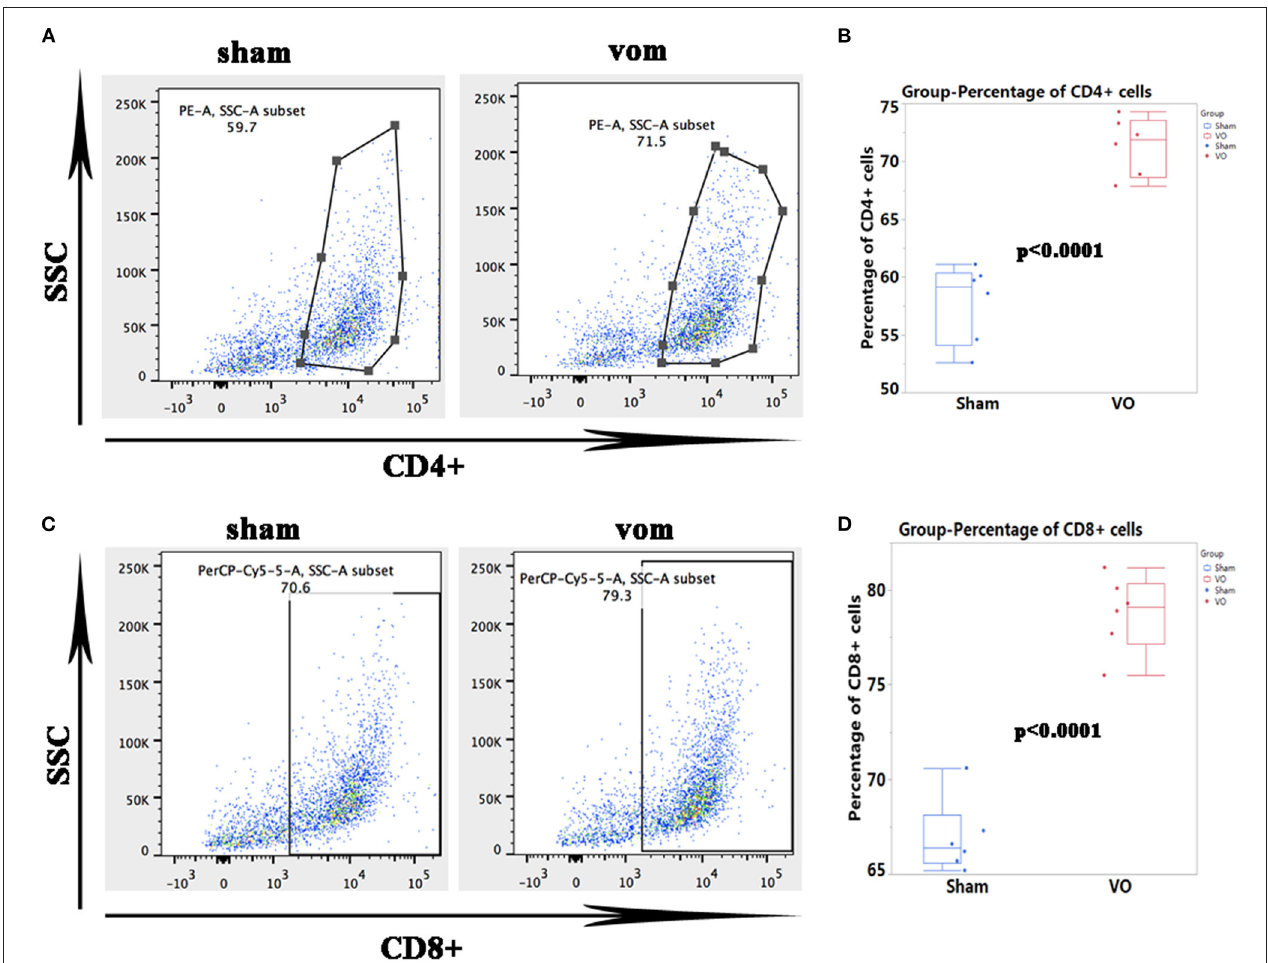
FIGURE 7 | Verification of the RNA-seq data by flow cytometric analysis of immune cells. (A) Representative dots of CD4 + cells. (B) Quantification of the percentage of CD4 + cells. (C) Representative dots of CD8 + immune cells. (D) Quantification of the percentage of CD8 +